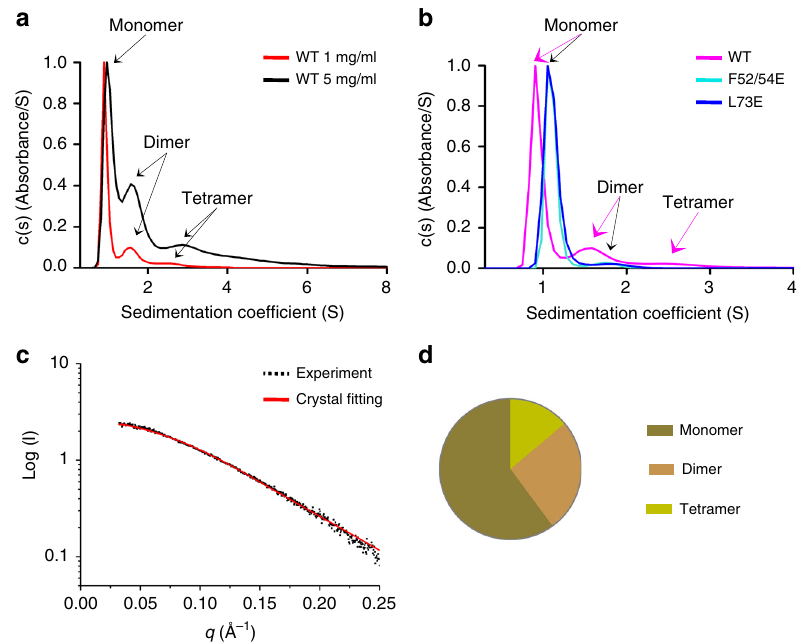
Fig. 2 Characterization of PML RING tetramers. a Analytical ultracentrifugation analysis of tetramerization of wild type PML RING, at 1 and 5 mg ml − 1 concentrations, respectively. b Analytical ultracentrifugation analysis of 1 mg ml − 1 PML RING, PML RING F52/54E and PML RING L73E . c SAXS characterization. Black dots, experimental data. Red line, the theoretical scattering pattern derived from mixs of PML RING multimers. d Oligomeric distribution estimated by SAXS analysis. The distribution of PML RING monomer (60.1%), dimer (26.1%) and tetramer (13.8%) was estimated using the OLIGOMER